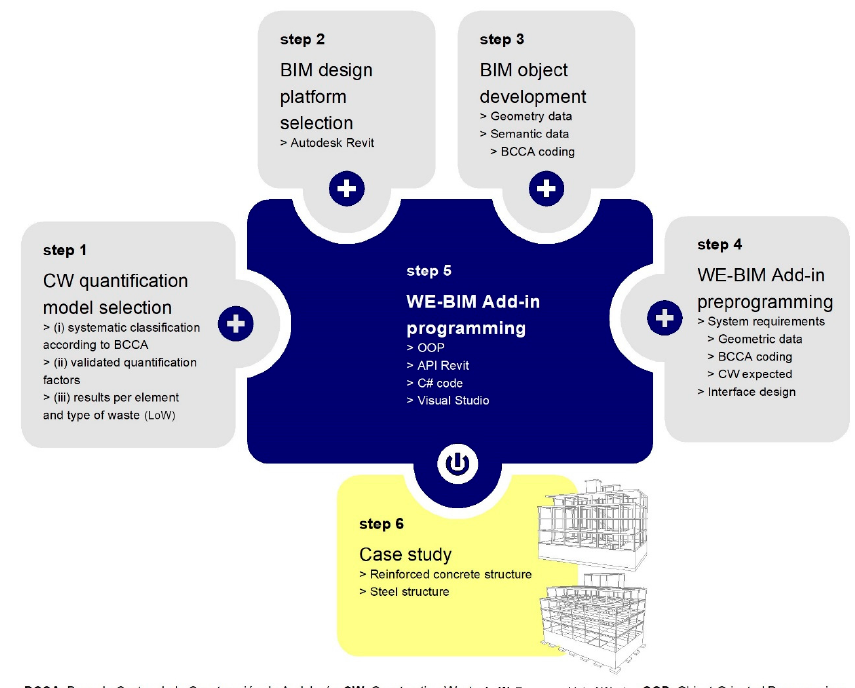
Figure 1. Flowchart of the developed